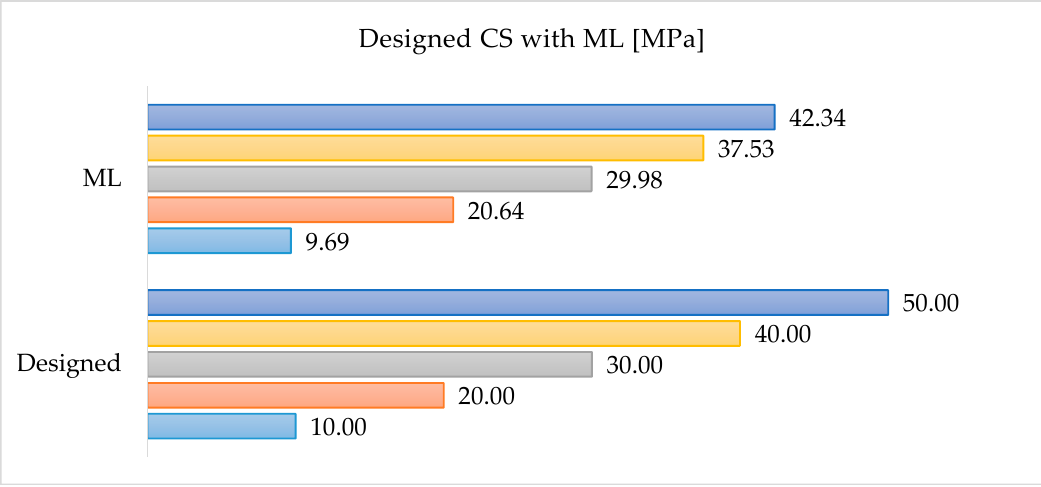
Figure 9. Comparison between designed Compressive Strength (CS) and calculated from Machine Learning (ML) formula.